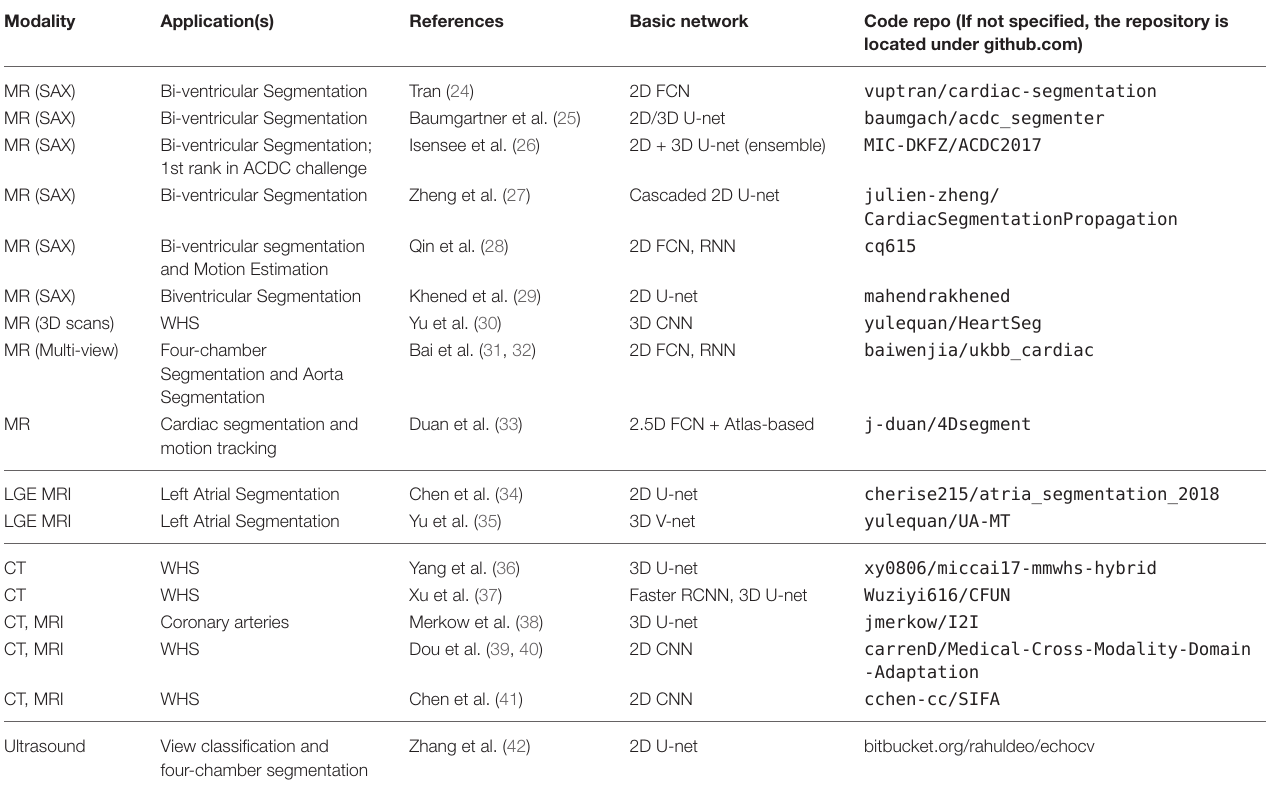
TABLE 7 | Public code for DL-based cardiac image